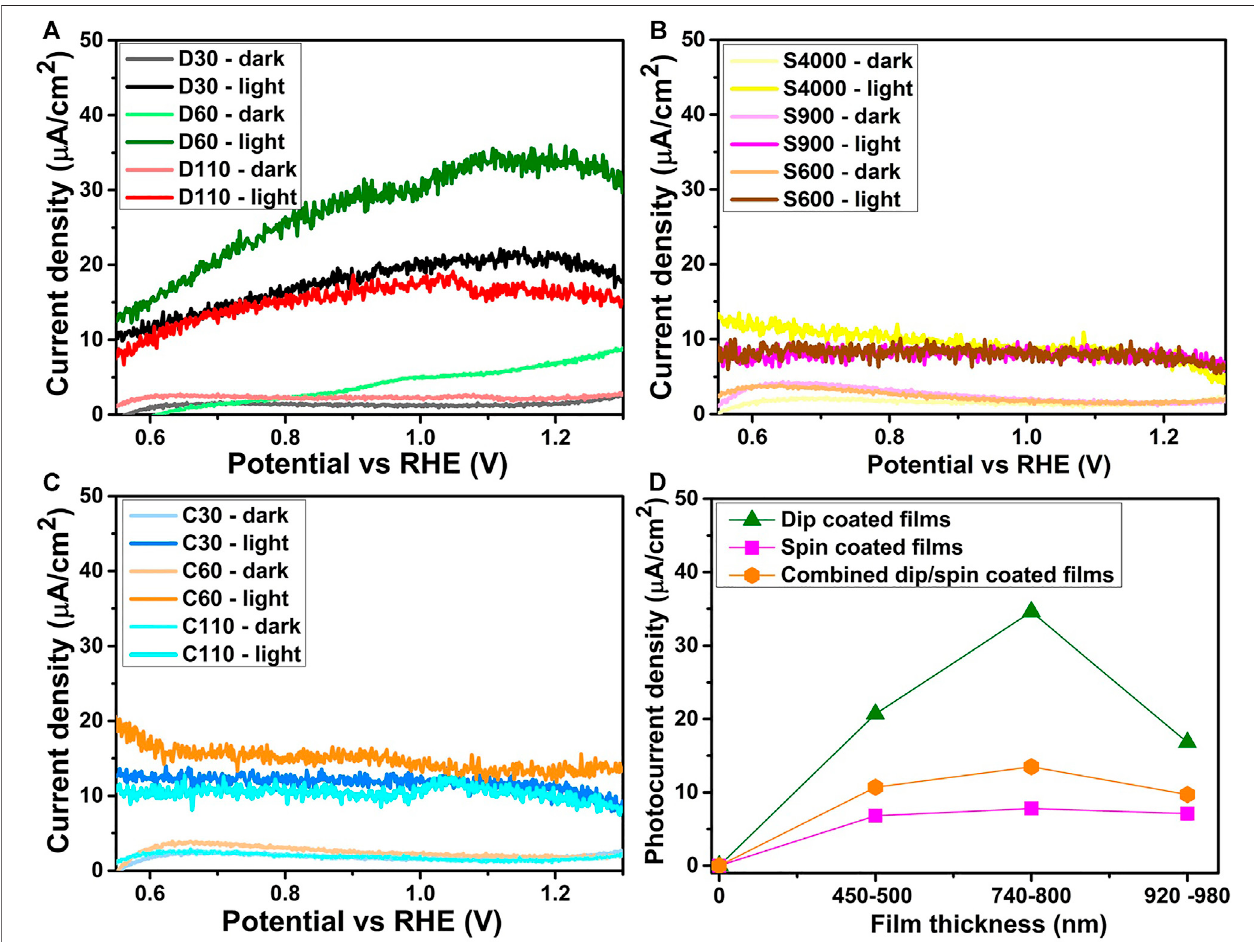
FIGURE 6 | Current density of α -Fe 2 O 3 fi lms prepared using the (A) dip (B) spin and (C) combined dip/spin coating techniques respectively (D) shows the photocurrent density obtained at 1.23V vs RHE for fi lms of various thickness ranges, prepared using different coating methods.